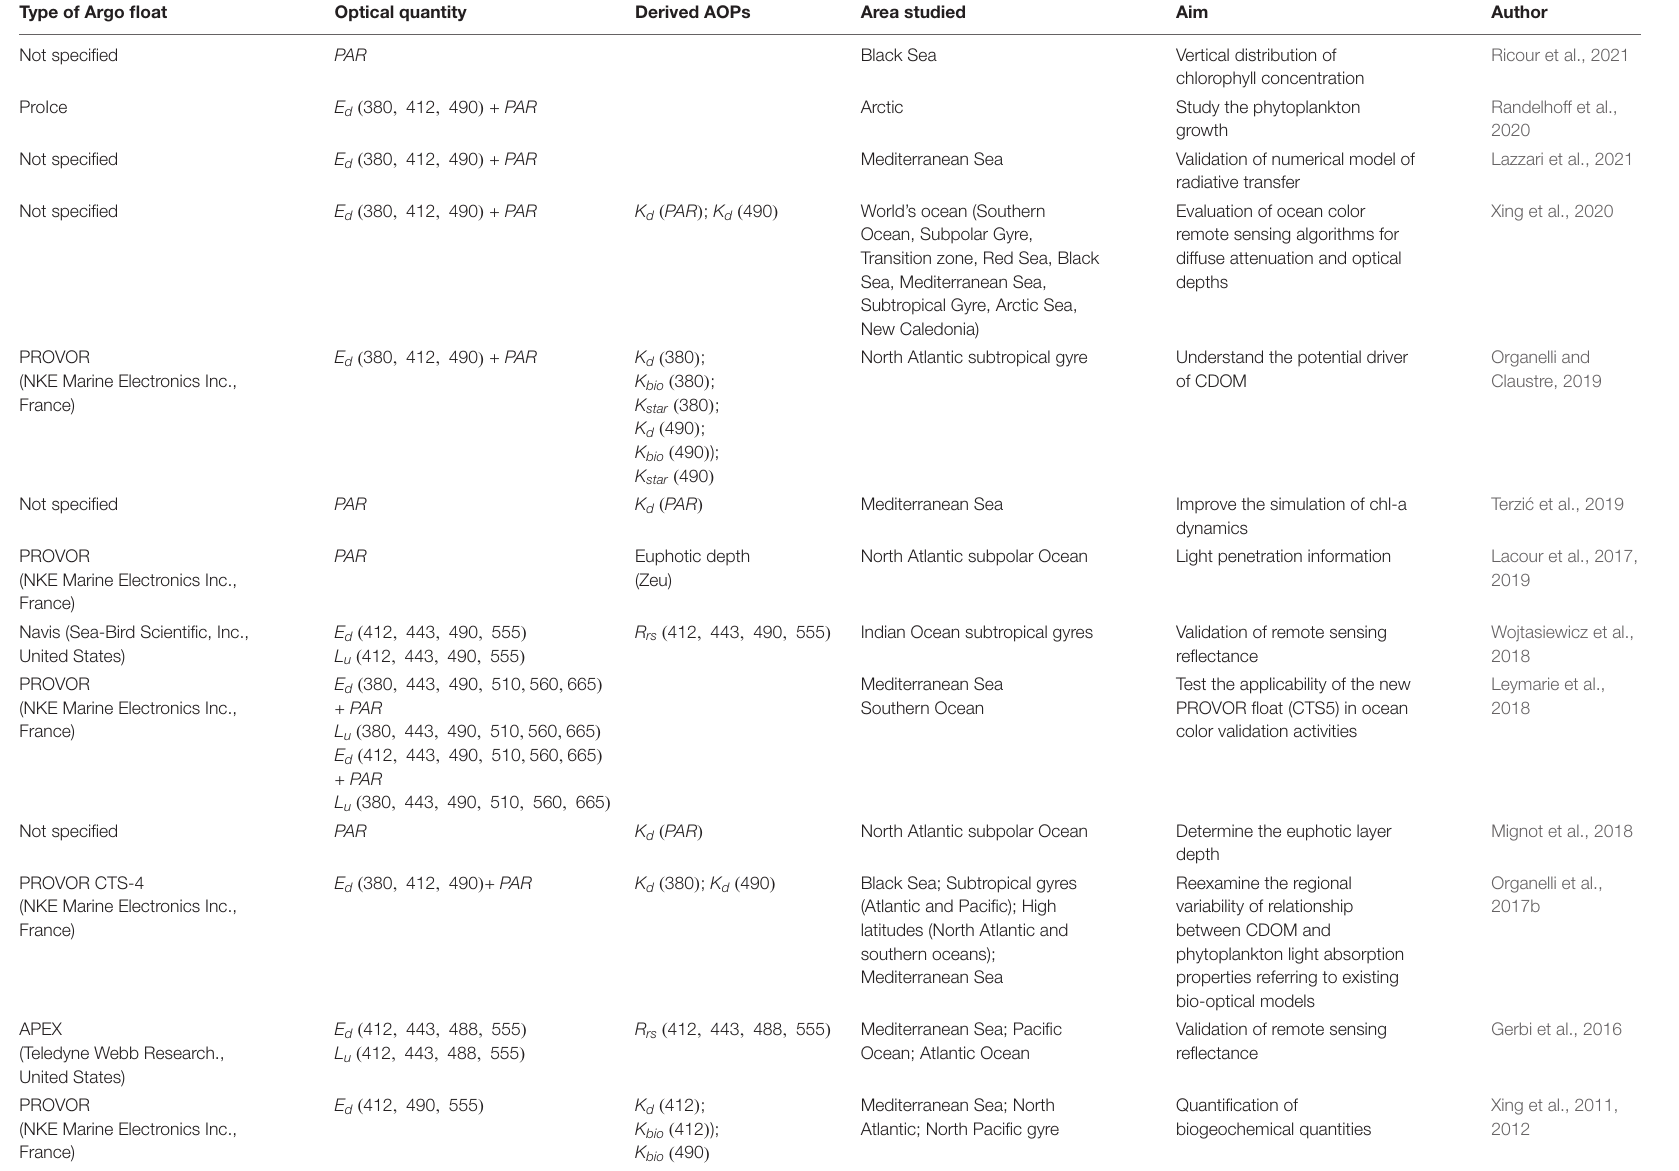
TABLE 1 | Summary of studies that used Argo radiometric data for their main research